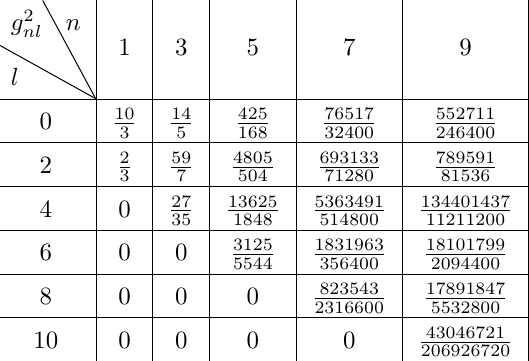
Table 2 . Numerical value of g 2